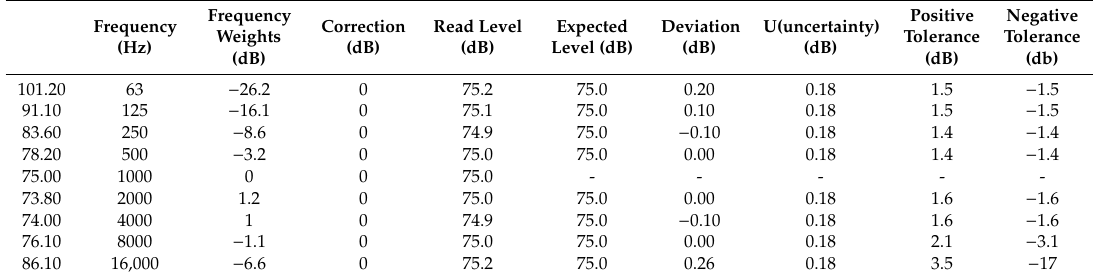
Table 2. Results obtained for the frequency weighting